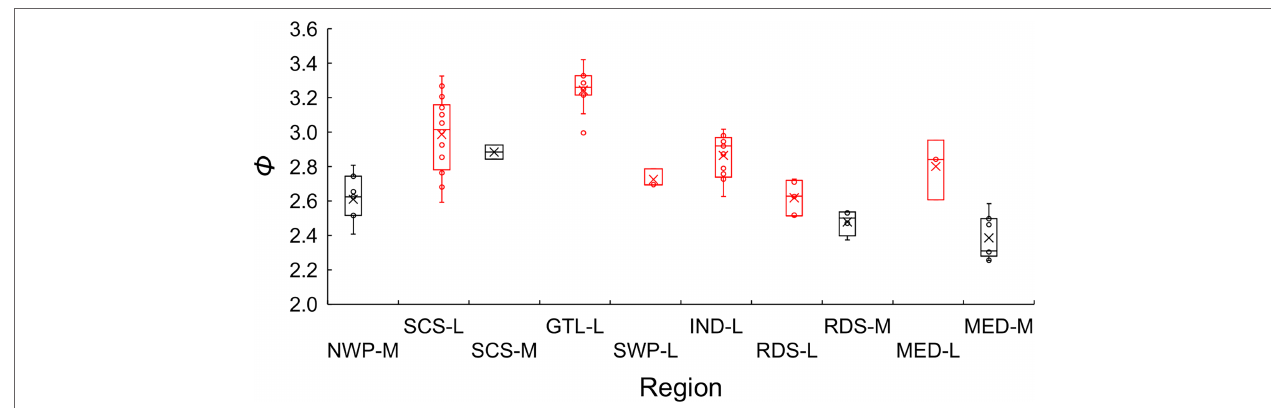
FIGURE 9 | Boxplots of the growth performance index ( φ ) of global growth parameter estimates for brushtooth lizardfish. NWP stands for the northwestern Pacific, SCS the South China Sea, GTL the Gulf of Thailand, SWP the southwestern Pacific, IND the Indian Ocean, RDS the Red Sea, and MED the Mediterranean Sea. The suffix of M indicates that the hard parts of fish was used as aging material (in black), and L indicates the length frequency data was used (in red). Cross signs in the plot indicate the